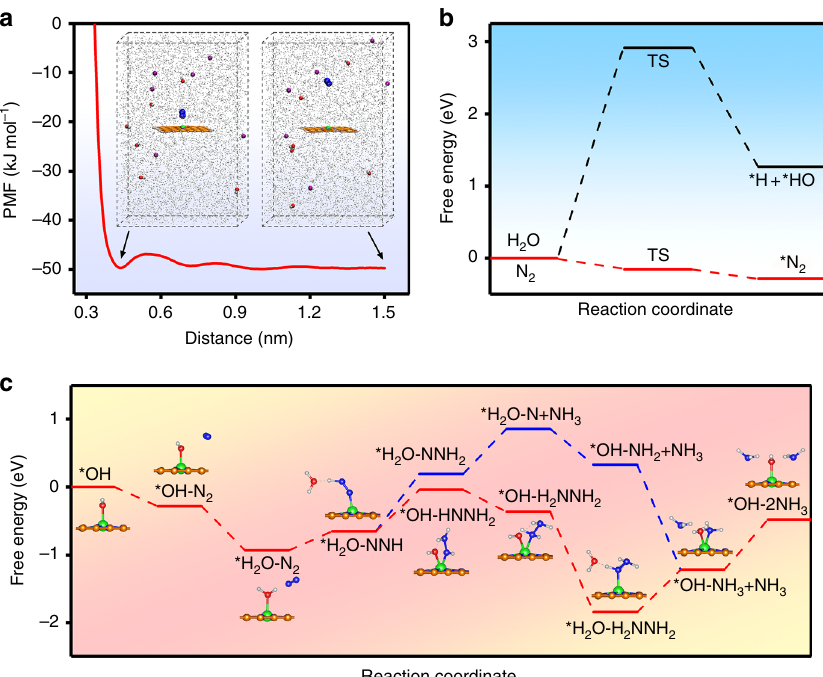
Fig. 4 Computational studies. a Potential of the mean force (PMF) for N 2 adsorption on the single-atom dispersed Fe – N – C (Fe SA – N – C) in 0.1 M KOH, inset: Molecular dynamics (MD) simulation snapshots at 0.45 and 1.5 nm, with N 2 , blue spheres; H 2 O, gray dots; OH − , red and white sticks; K + , purple spheres. b Calculated energy barriers of the adsorption of hydrogen and nitrogen. c Free energy diagram for the nitrogen reduction reaction (NRR) on the Fe SA – N – C catalyst at U = 0 V. Inset models represent the corresponding adsorbates. The orange, blue, red, green, and gray spheres represent C, N, O, Fe, and H atoms,